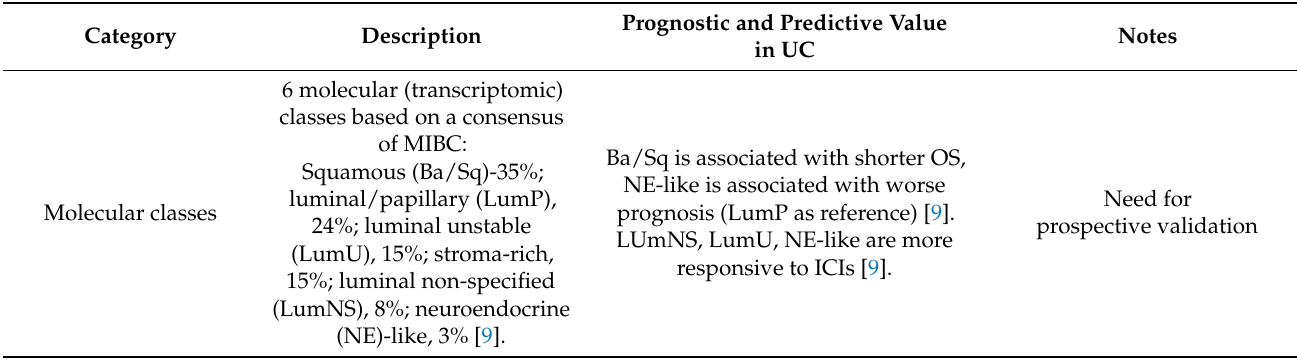
Table 1. Molecular factors and their prognostic and predictive value in UC patients, with a particular focus on ICIs. Category Description